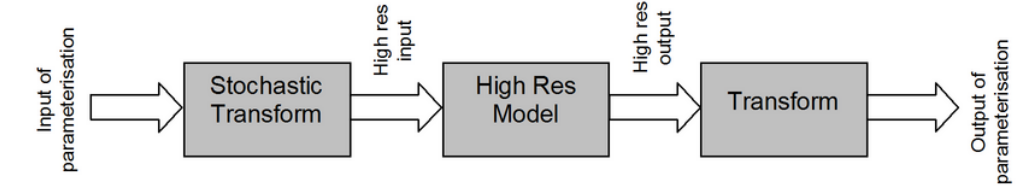
Fig. 1. Schematic of a wrapped, high-resolution